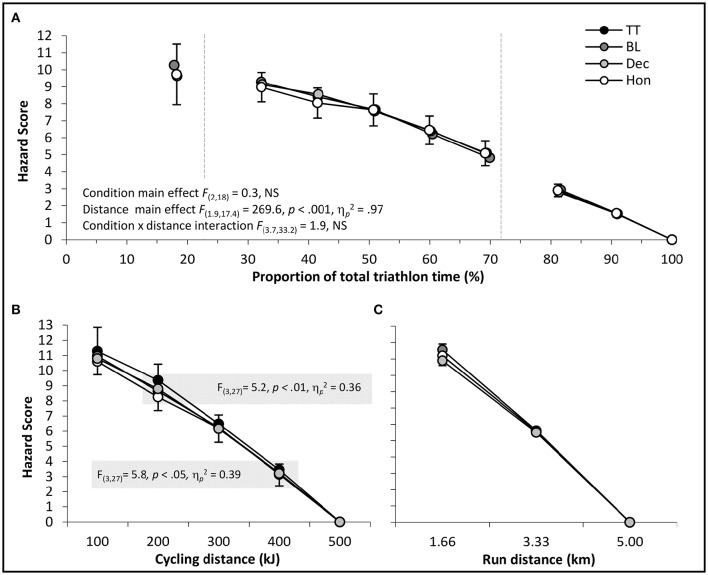
Mean ± SD Hazard Scores in relation to (A) the proportion of total triathlon distance remaining, (B) the proportion of the bike section remaining, (C) the proportion of run distance remaining (dashed lines indicate transition end).